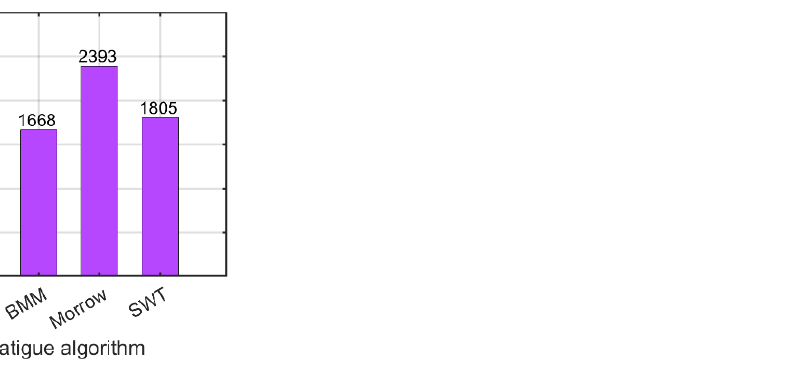
Figure 20. Number of logarithmic life repeats of the nutless bolt connection for the different fatigue algorithms used.